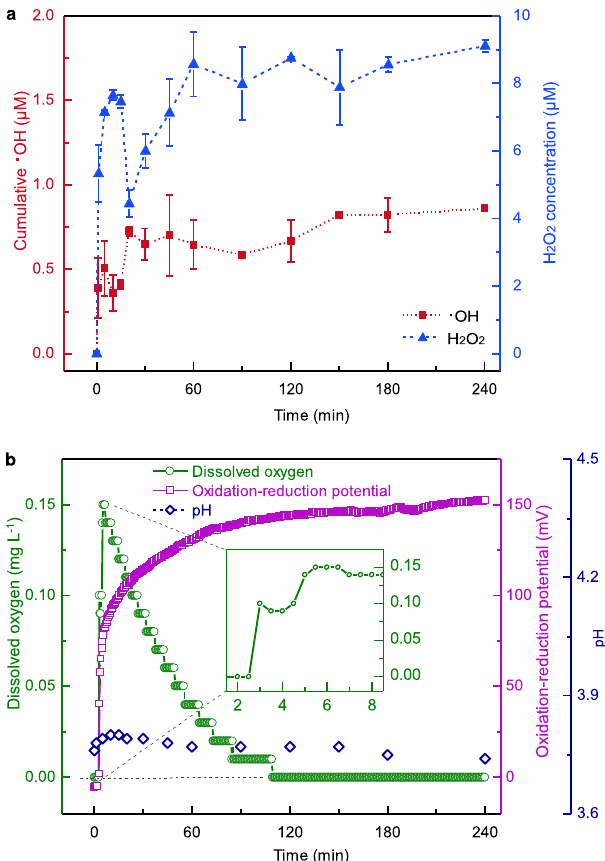
Fig. 2 Time-course of • OH, H 2 O 2 , and O 2 concentrations in quartz-water interface reactions. a The cumulative • OH ( fi lled square) and the concentration of H 2 O 2 ( fi lled triangle) in the suspension of quartz ground in N 2 atmosphere for 5 h. The error bars present standard deviations of two independent replicates. b The variations of dissolved oxygen concentrations (open circle), oxidation-reduction potential (open square), and pH (open diamond) in the reactions. All the independent experiments were conducted in duplicate using water with dissolved oxygen <0.01 mg L − 1 in a glovebox with N 2